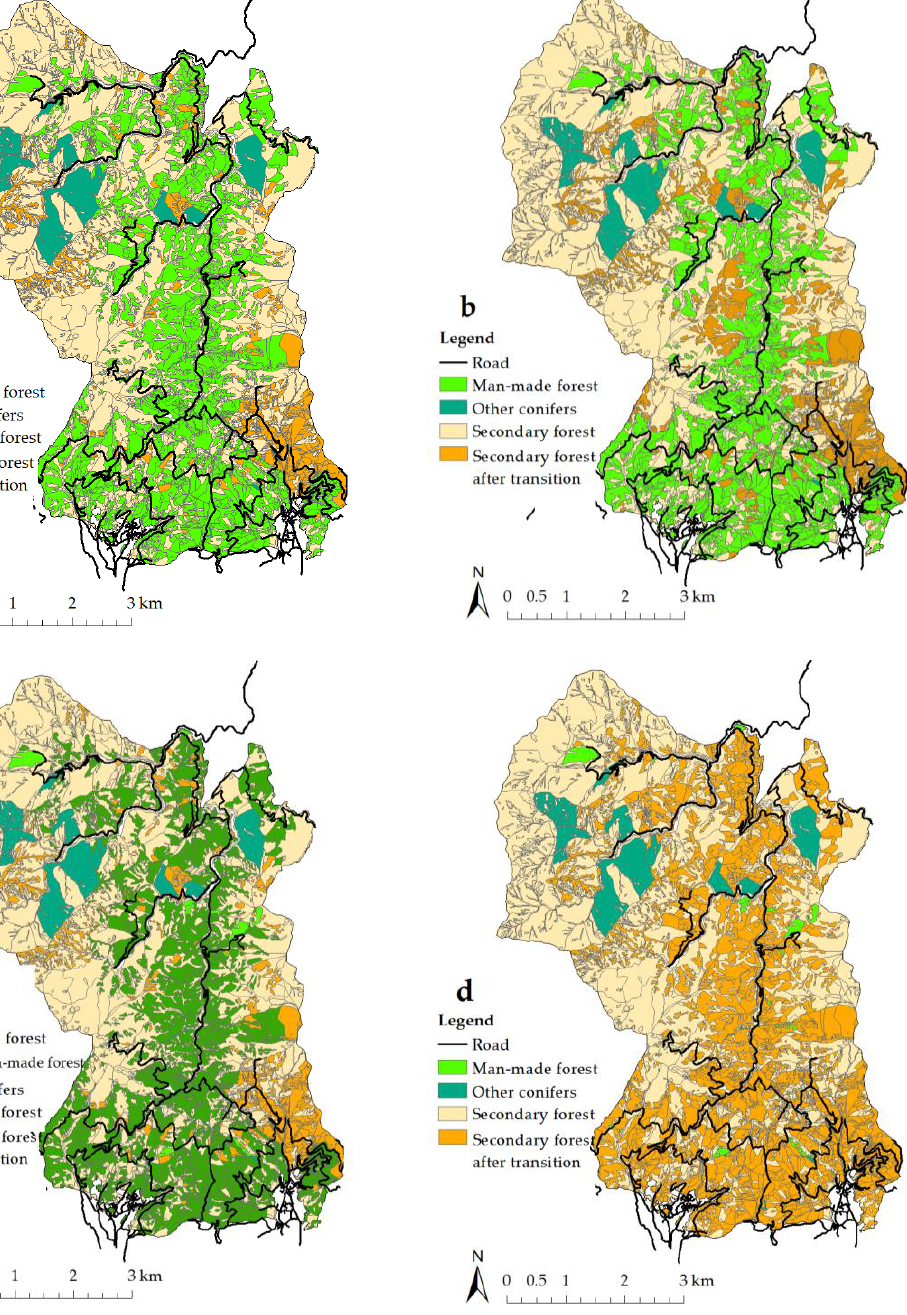
Figure 11. Future forest physiognomies based on each plan; ( a ) forestry high impact plan (Plan 1), ( b ) forestry high impact plan focusing on locality class (distance to road) (Plan 2), ( c ) environmental conservation plan (Plan 3), and ( d ) environmental plan with greater emphasis on site quality class (Plan 4).